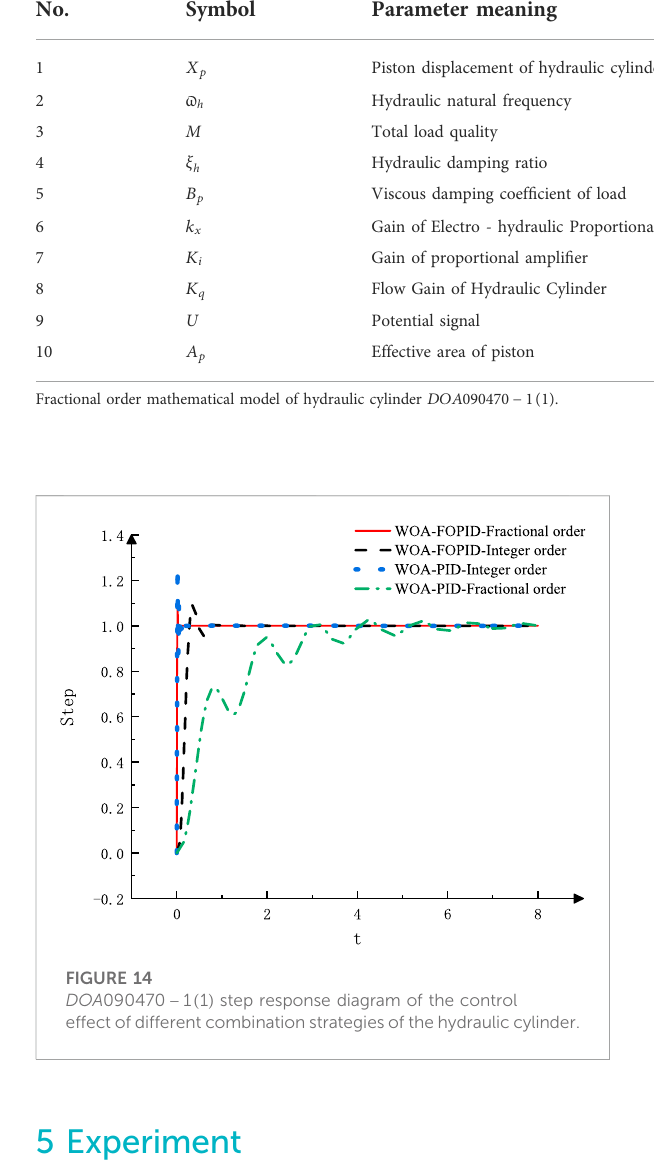
TABLE 4 Doa090470-1 (1) hydraulic cylinder parameter table.